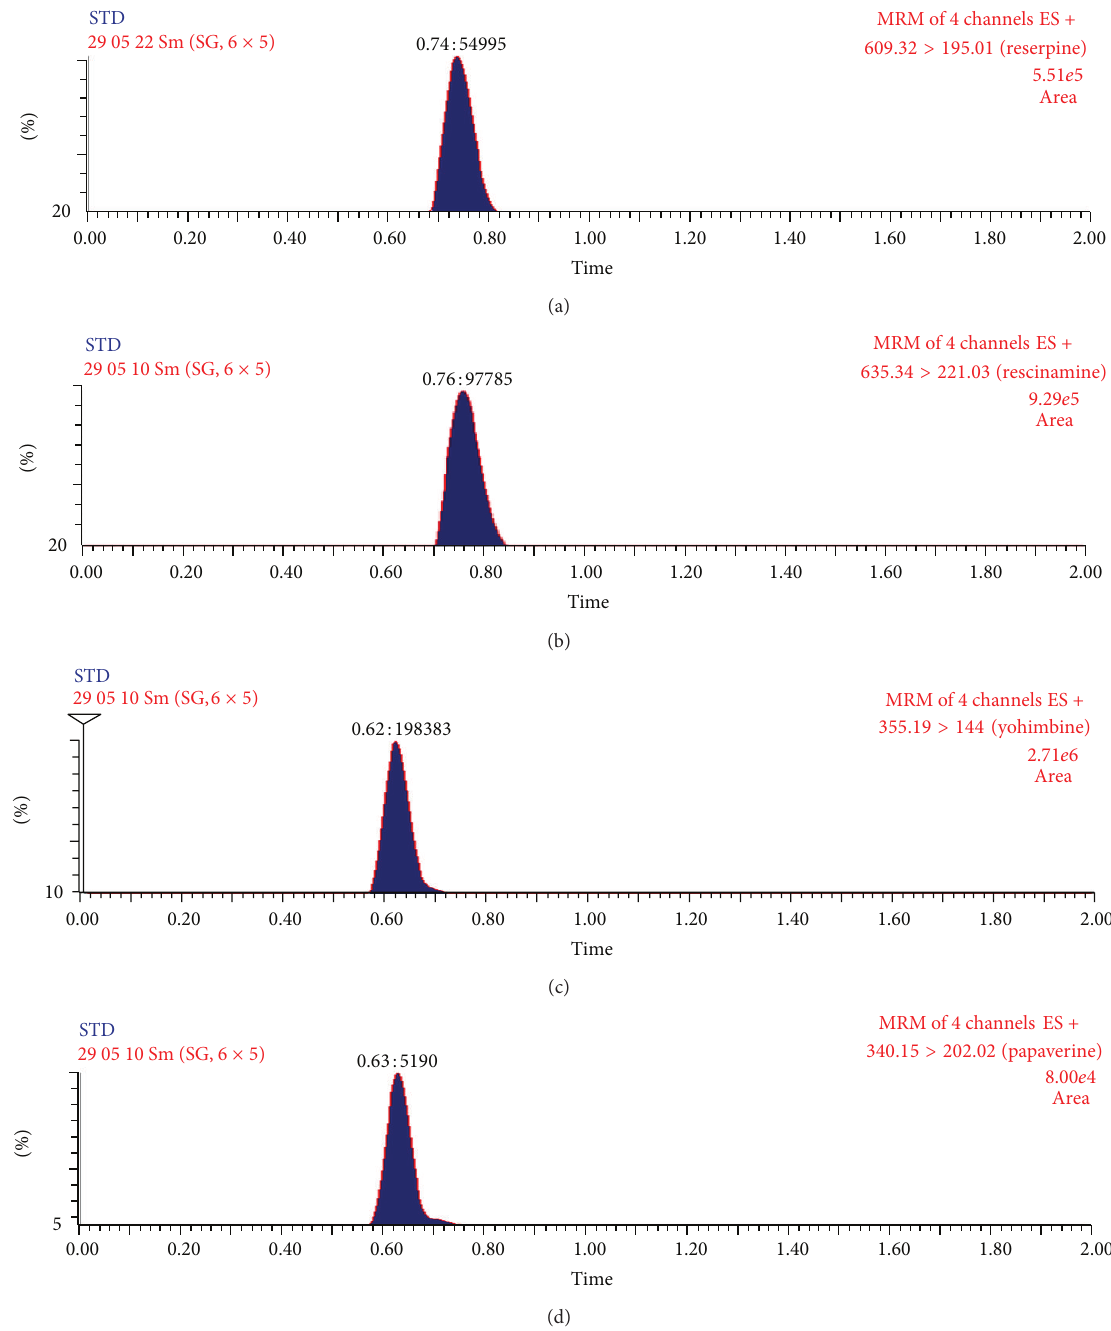
Figure 6: Representative MRM chromatograms at ULOQ level of reserpine (a), rescinnamine (b) yohimbine (c) and papaverine (d).